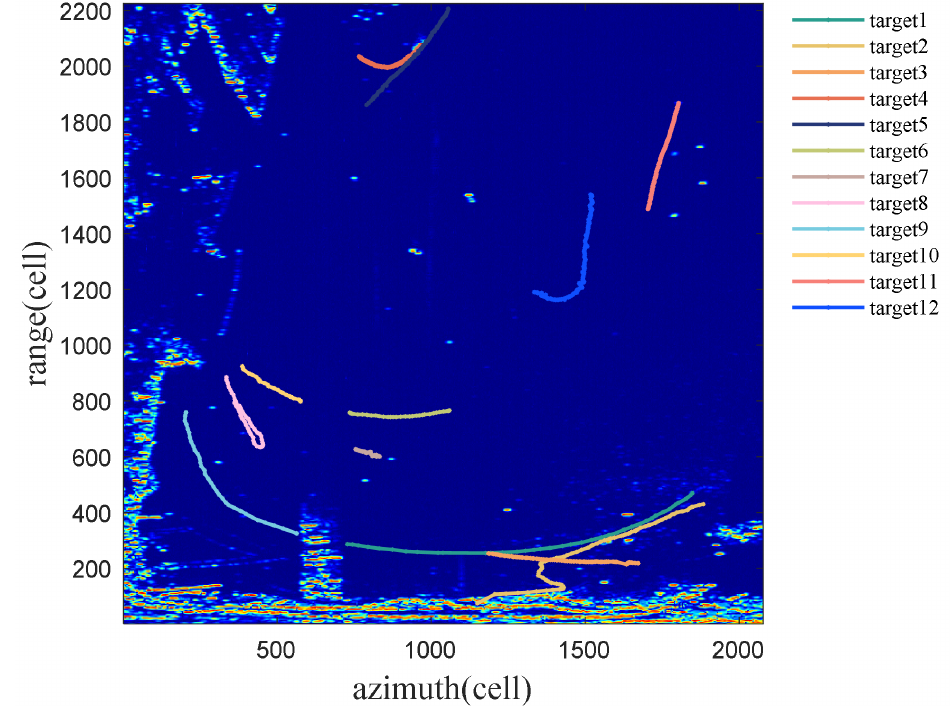
Figure 4. The tracking results of the proposed